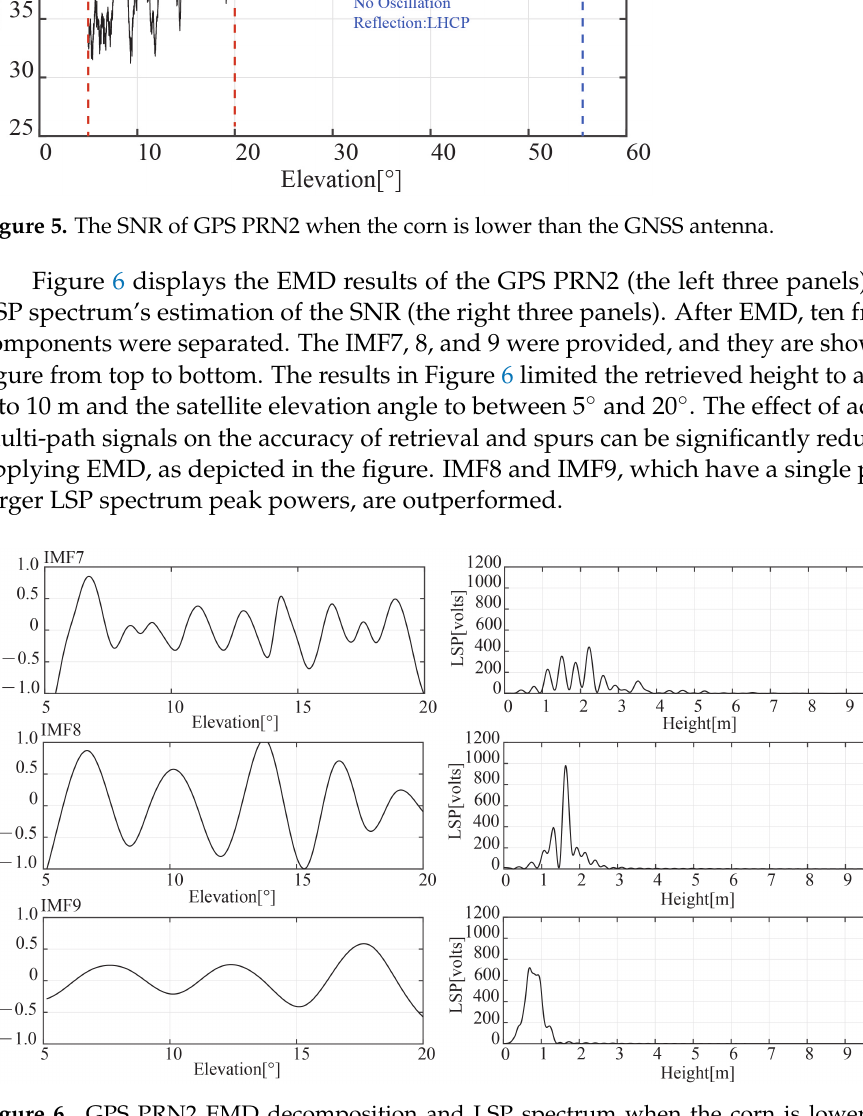
Figure 6. GPS PRN2 EMD decomposition and LSP spectrum when the corn is lower than the GNSS